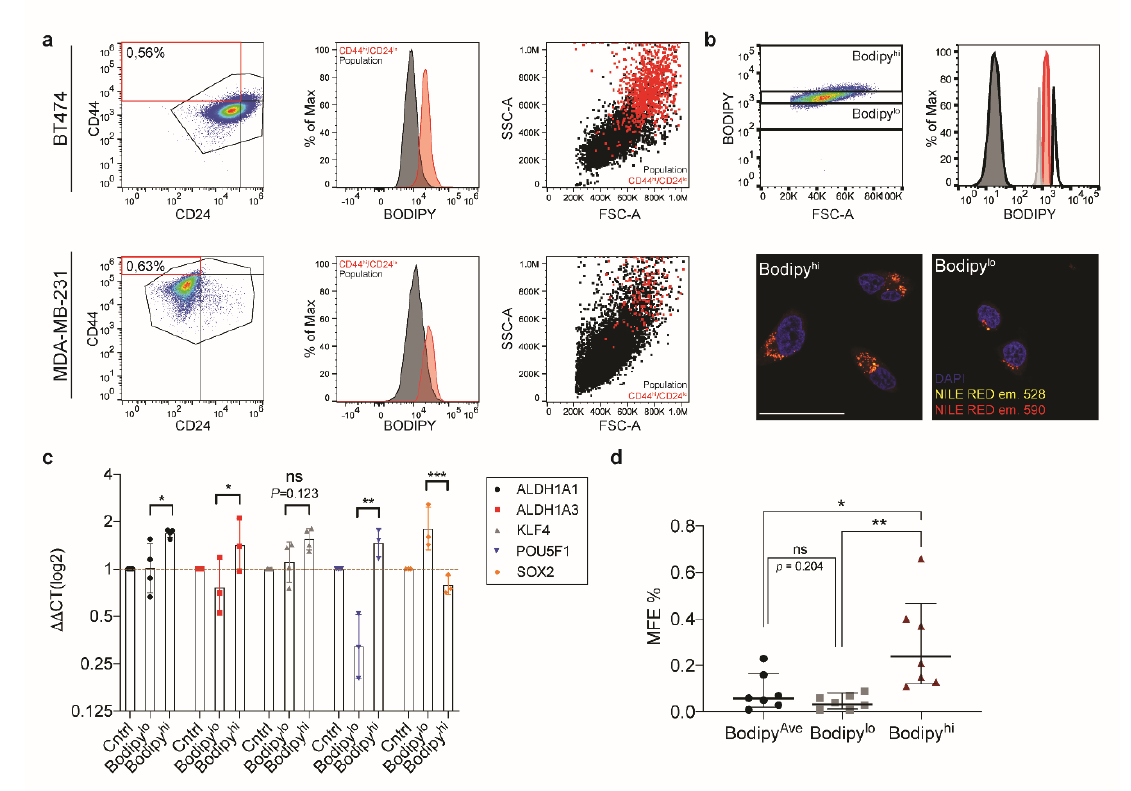
Figure 3. Lipid droplet hi populations are enriched for stem cell markers in BT474 ( a ) FACS-based analysis of CD44 hi /CD24 lo populations in BT474 and MDA-MB-231. Scatter plot showing the distribution of the two surface markers (left), the histogram of MFI for BODIPY TM in CD44 hi /CD24 lo (red) versus total population (black; middle), the dot plot to highlight SSC distribution of CD44 hi /CD24 lo (red) versus total population (black). ( b ) Scatter plot for FITC (BODIPY TM ) versus FSC illustrating the gating strategy for FACS sort, with histogram for FITC (BODIPY TM ) levels in sorted BT474 populations. Confocal microscopy of Nile Red stained sorted populations. The scale bar represents 50 μ m. ( c ) Quantitative PCR to analyze the expression of a panel of genes associated with stemness for the three sorted populations from BT474. Data are represented as geometric mean ± SD ( d ) Mammosphere formation efficiency for the three sorted populations from BT474 ( n = 7). Data are represented as geometric mean ± SD. Significance was calculated using the two-tailed t -test. * p < 0.05, ** p < 0.01, *** p < 0.001.